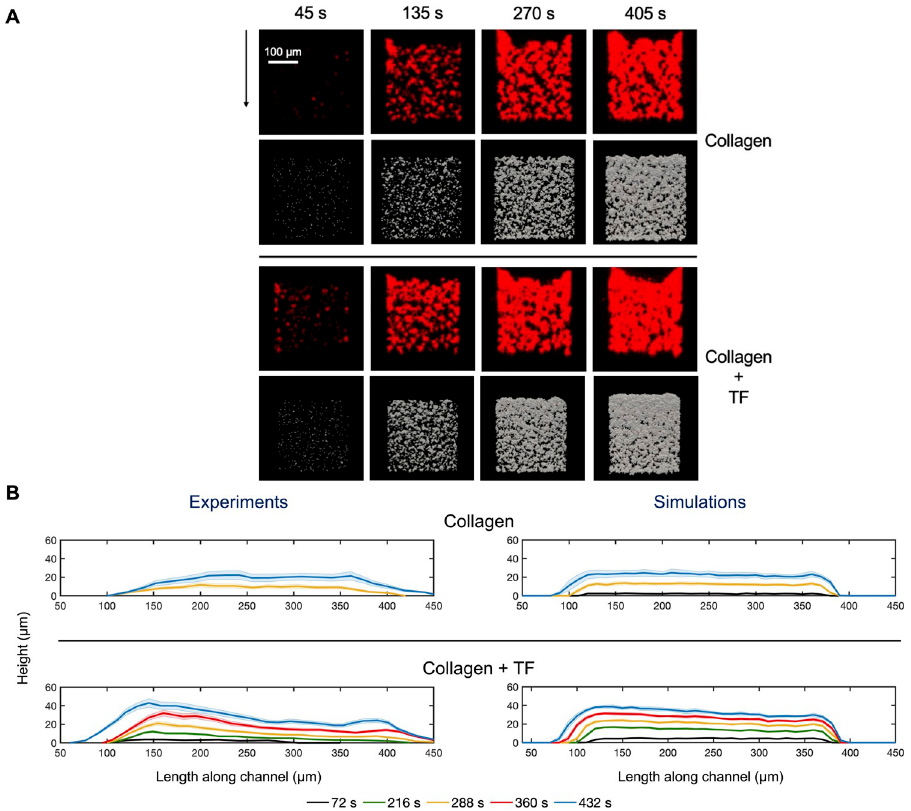
Fig 4. Comparison between model predictions and typical clot morphologies observed in microfluidic perfusion experiments. (A) Model predictions of deposited platelets (gray) agree well with fluorescent micrographs of thrombi observed over time in experiments (red). (B) Comparison between model predictions and clot heights observed in microfluidic perfusion experiments. Profiles represent average aggregate height determined using vertical line scans in the direction of flow over collagen or collagen with TF.